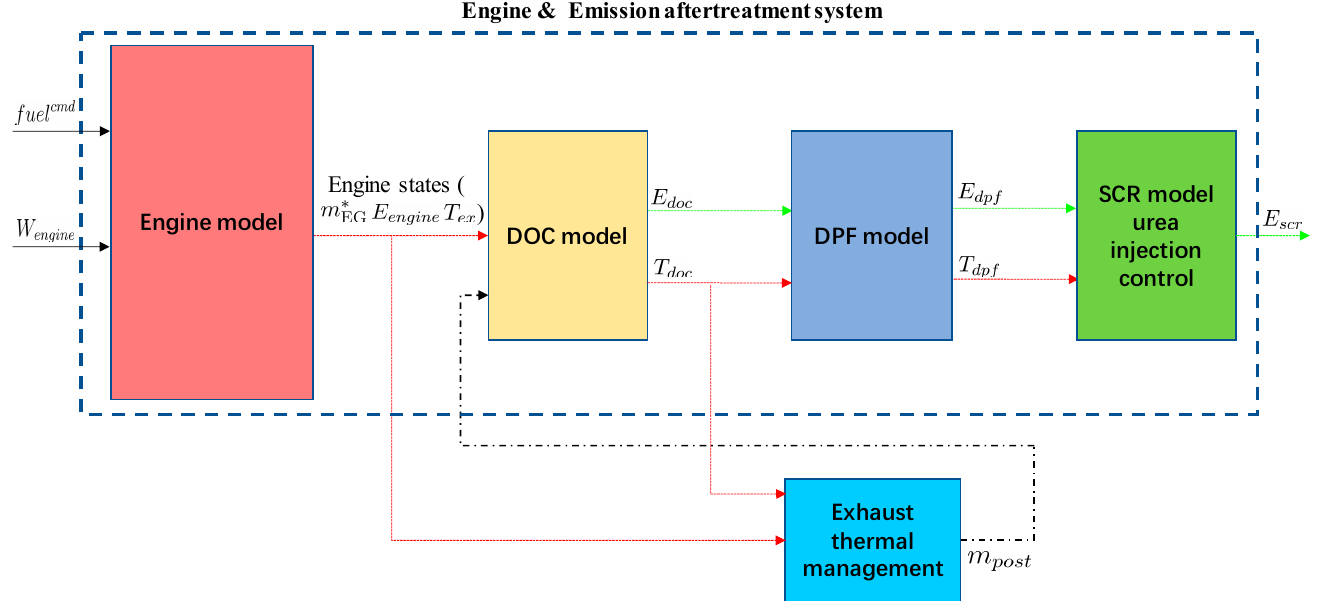
Figure 3. Schematic of the engine and emission aftertreatment system and exhaust thermal management model.